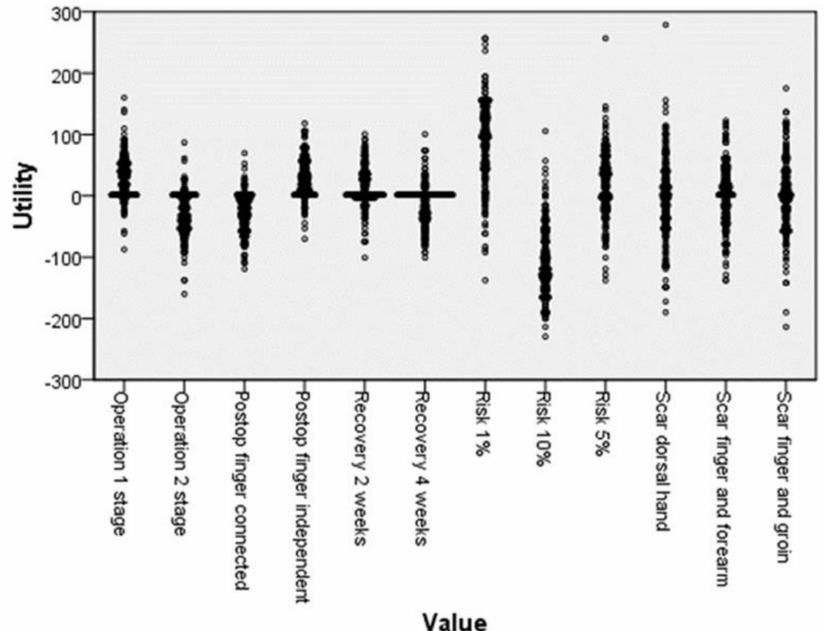
Figure 4. Distribution of the utility level, showing a wide variety of choices among